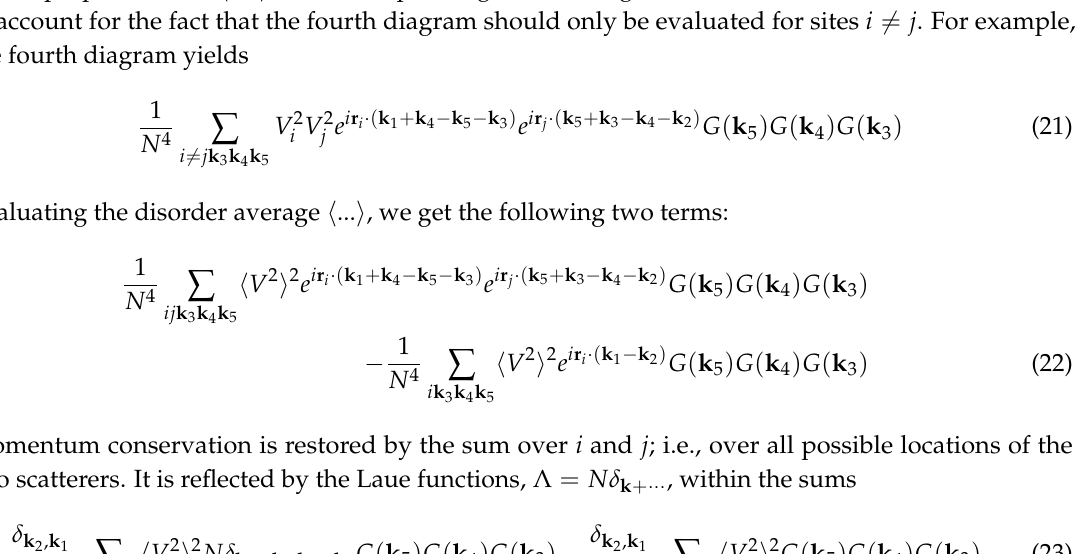
Figure 12. The first few graphs in the irreducible self-energy of a diagonally disordered system. Each represents the scattering of a state k from sites (marked X ) with a local disorder potential distributed according to some specified probability distribution P ( V ) . The numbers label the k states of the fully dressed Green’s functions, represented by solid lines with